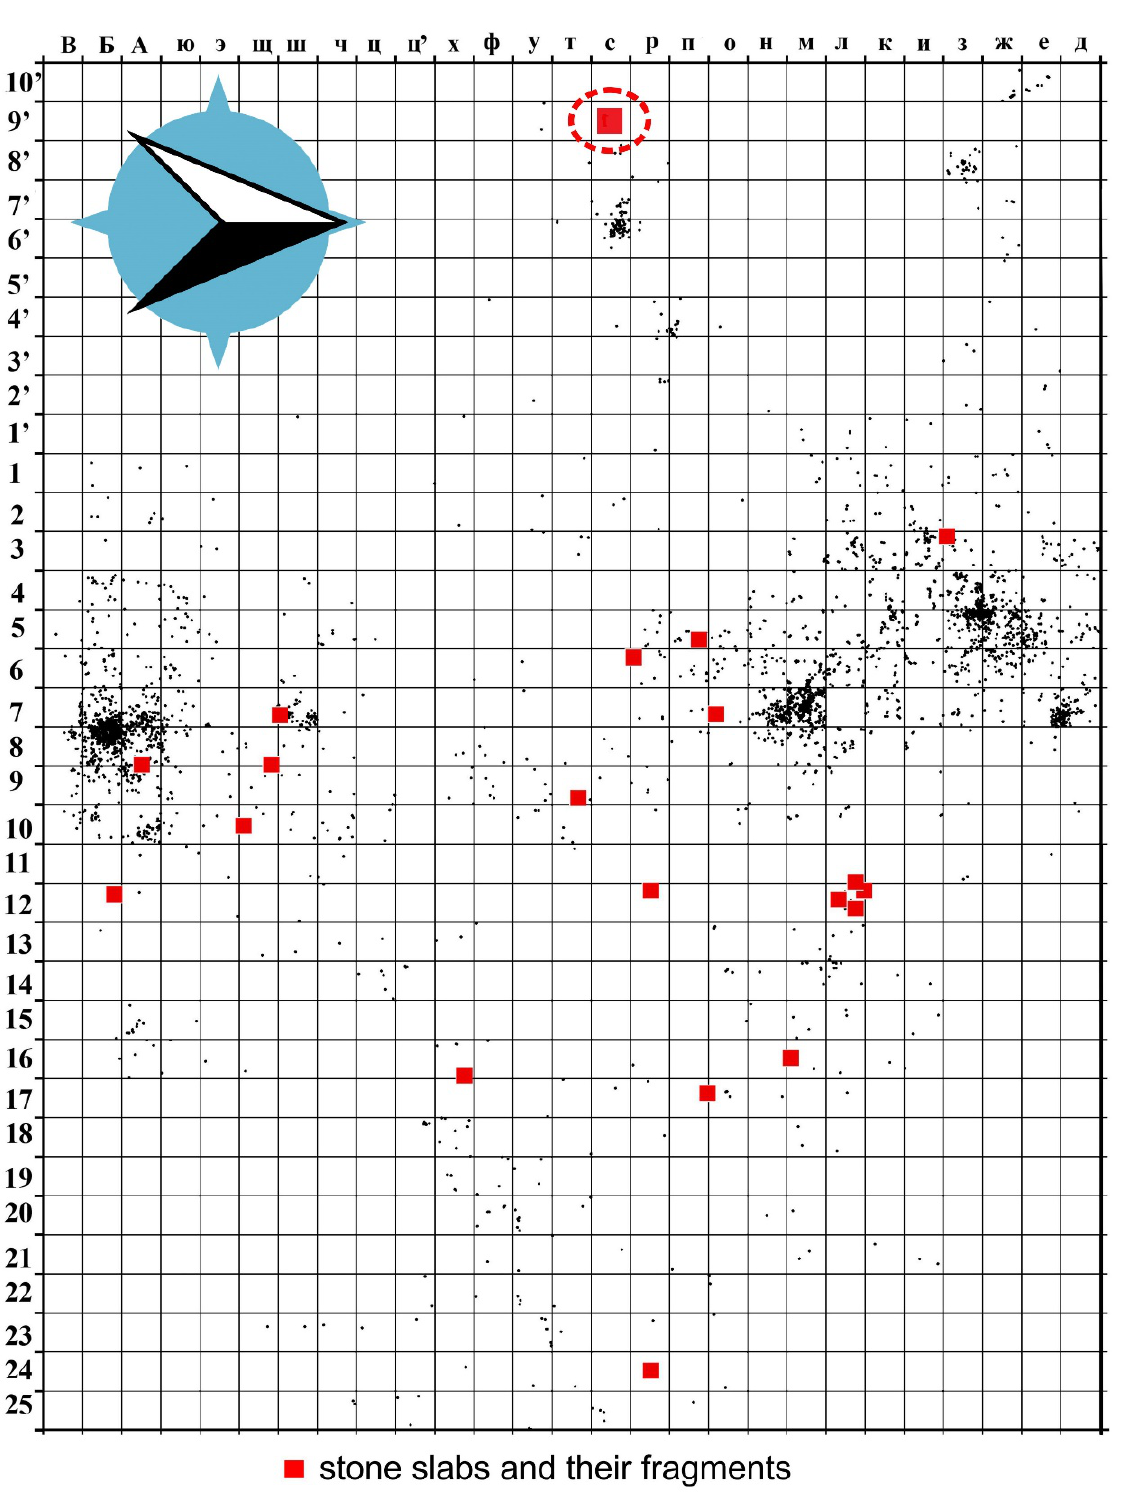
Figure 3. Kamennaya Balka II site: bottom layer. Plan of finds with stones and slabs. The studied slab is located in grid c9´. A red square was enlarged to show the right